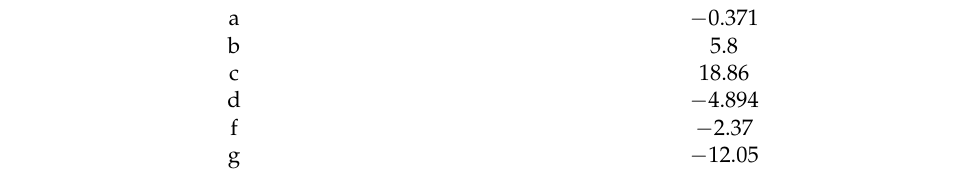
Table 8. Coefficients for the fitting fuction of Pepper.